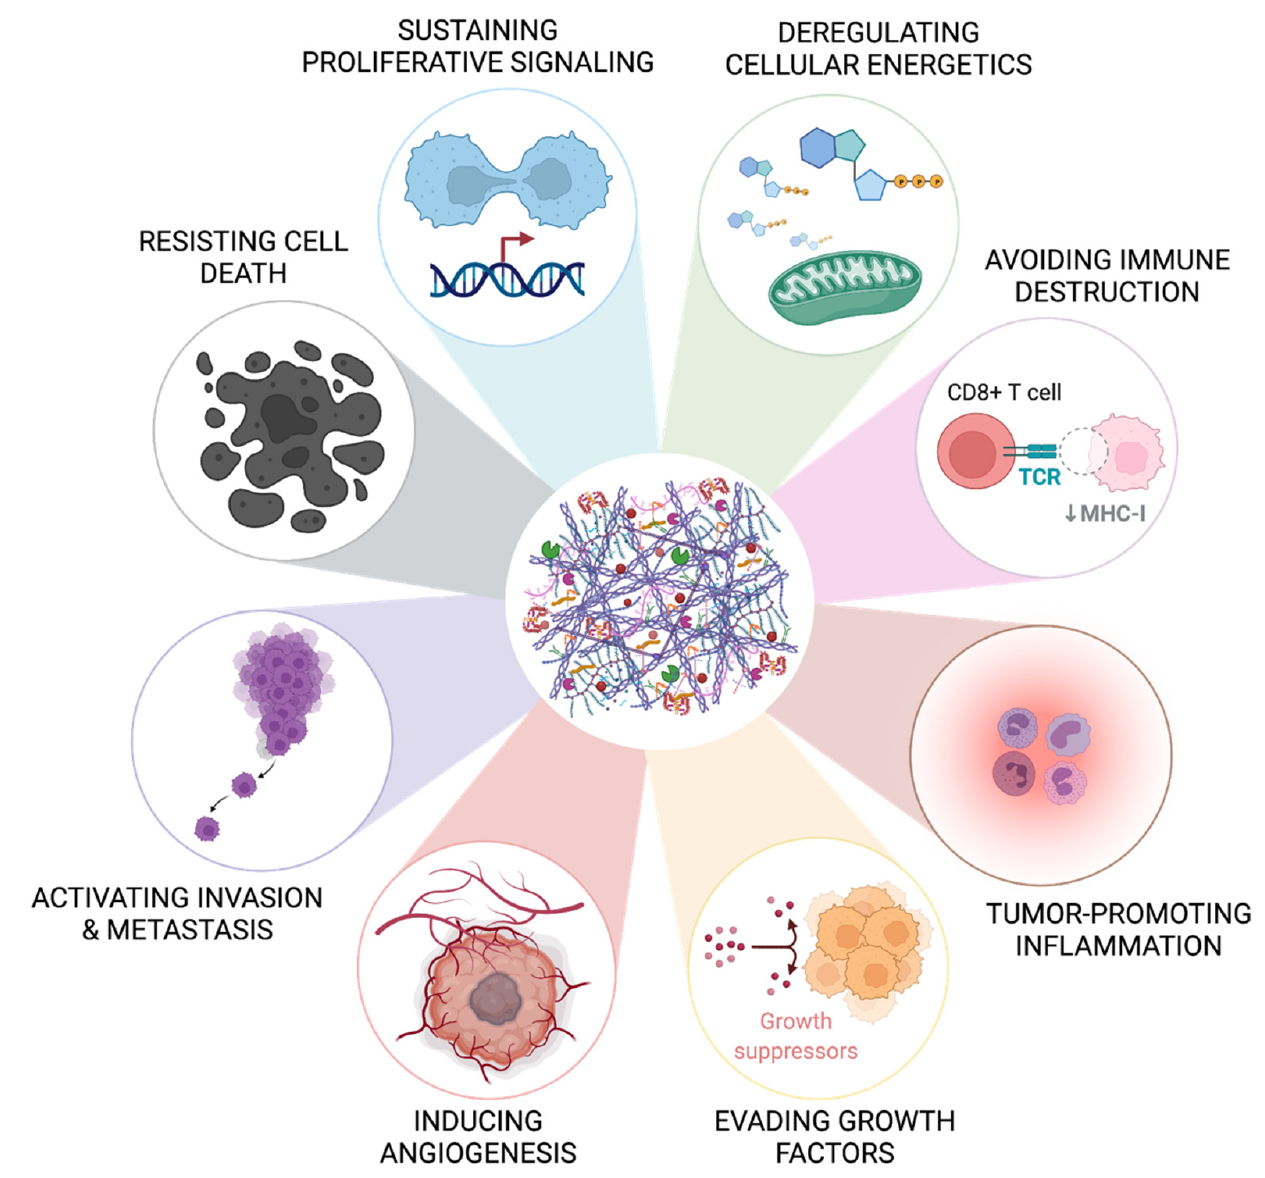
Figure 1. The extracellular matrix contributes to the hallmarks of cancer. The bioactive role of the extracellular matrix has been described to be involved in eight of the ten well-known hallmarks of cancer reported by Hanahan and Weinberg in 2011 [8], namely in resisting cell death, sustaining proliferative signaling, deregulating cellular energetics, avoiding immune destruction, tumor-promoting inflammation, evading factors, inducing angiogenesis, and activating invasion and metastasis. The influence of the extracellular matrix in the other two hallmarks (genome instability and mutation and enabling replicative immortality) is not yet fully characterized in CRC. Created with BioRender.com (accessed on 10 November 2021).